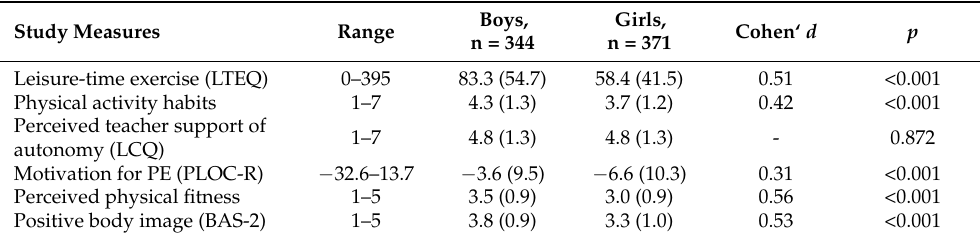
Table 1. The comparison of the study measures between boys and girls, m (SD), n = 715.